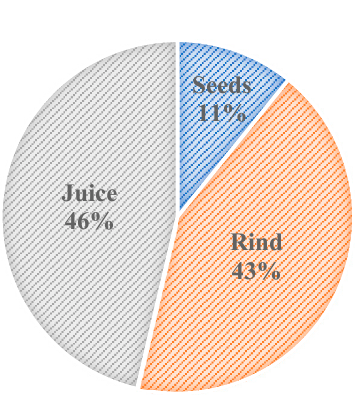
Figure 2. Weight Percent Composition of Pomegranate [10,13,14].